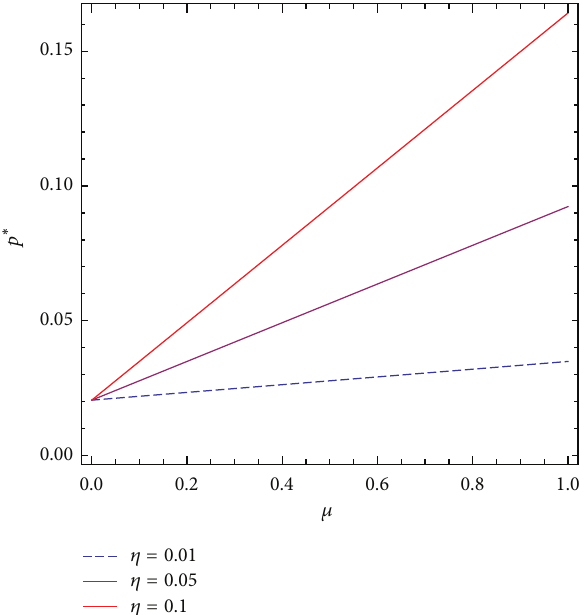
Figure 6: The optimal reinsurance proportion varies with respect to 𝜇 at different 𝜂